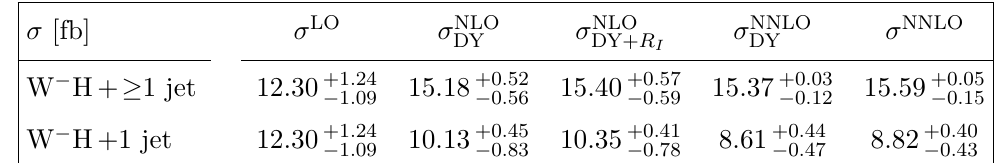
Table 2. The fiducial cross sections for inclusive ( ≥ 1 jet) (top line) and exclusive (1 jet) (bottom line) associated to W − H + jet process according to the setup of section 3 and the cross section expressions and labelling as defined in section 2.3. The theory error on the values represents the minimum and maximum from the 7-point scale variation. See main text for details.